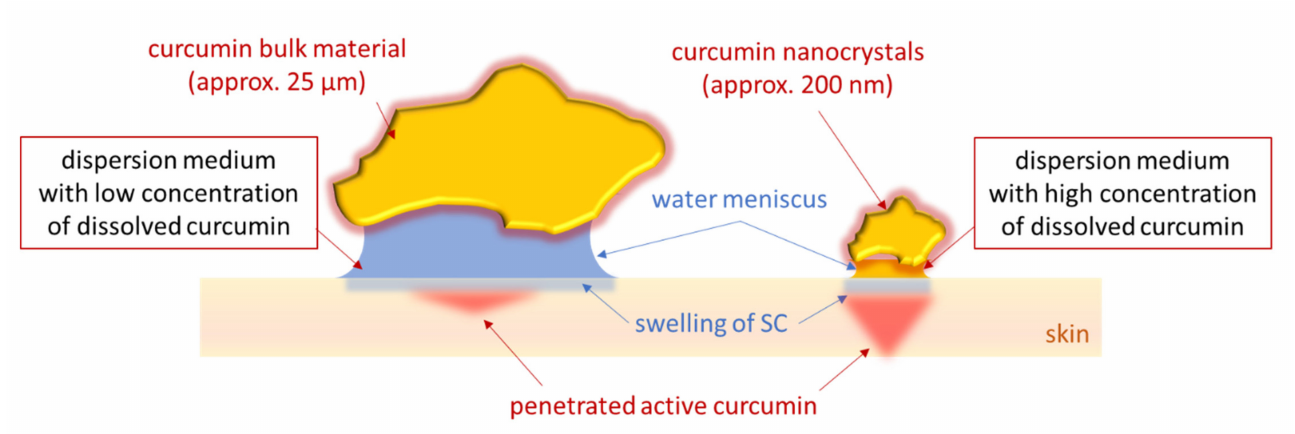
Figure 8. Scheme of suggested mechanism of passive dermal penetration of active compounds from particle-containing formulations (explanations c.f.